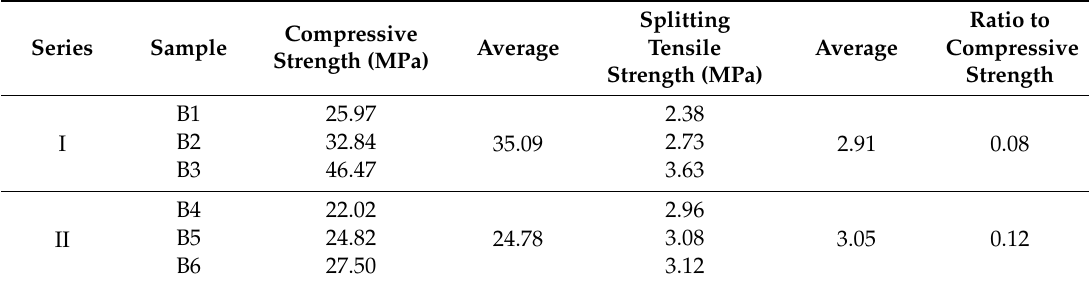
Table 4. Compressive and splitting tensile strength of geopolymer concrete.